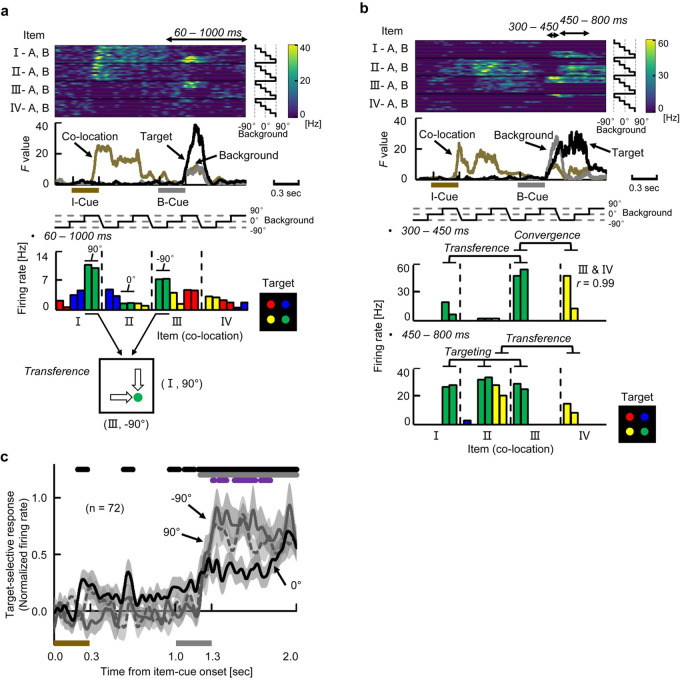
Construction of goal-directed information.(a) Example neuron showing the “transference” effect ([I, 90°] and [III, −90°] for the bottom-right). Same format as Fig 5A. Bottom panel shows a schematic diagram of “transference” from the retrieved location (co-locations I and III) into the same target location (bottom right, green). (b) Example neuron showing multiple operations. (c) Target-selective responses (“best” minus “others”) in trials with −90°, 0°, and 90° background cues for target-selective neurons (n = 72). Curves and shadings depict means and SEMs of population-averaged SDFs. Top lines, time duration in which target-selective responses (“best” minus “others”) were significantly positive in trials with 0° background cues (black) and with either −90° or 90° background cues (gray) (P < 0.05, t test, 2-tailed). Purple line, time duration in which the “best” target responses were significantly larger in trials with either −90° or 90° compared with 0° background cue (P < 0.05). The best target locations of the target-selective neurons in each hemisphere (animal) covered not only the contra-lateral side but also ipsi-lateral side (S2 Table). Source data are available in S1 Data. B-Cue, background cue; I-Cue, item cue; SDF, spike density function.